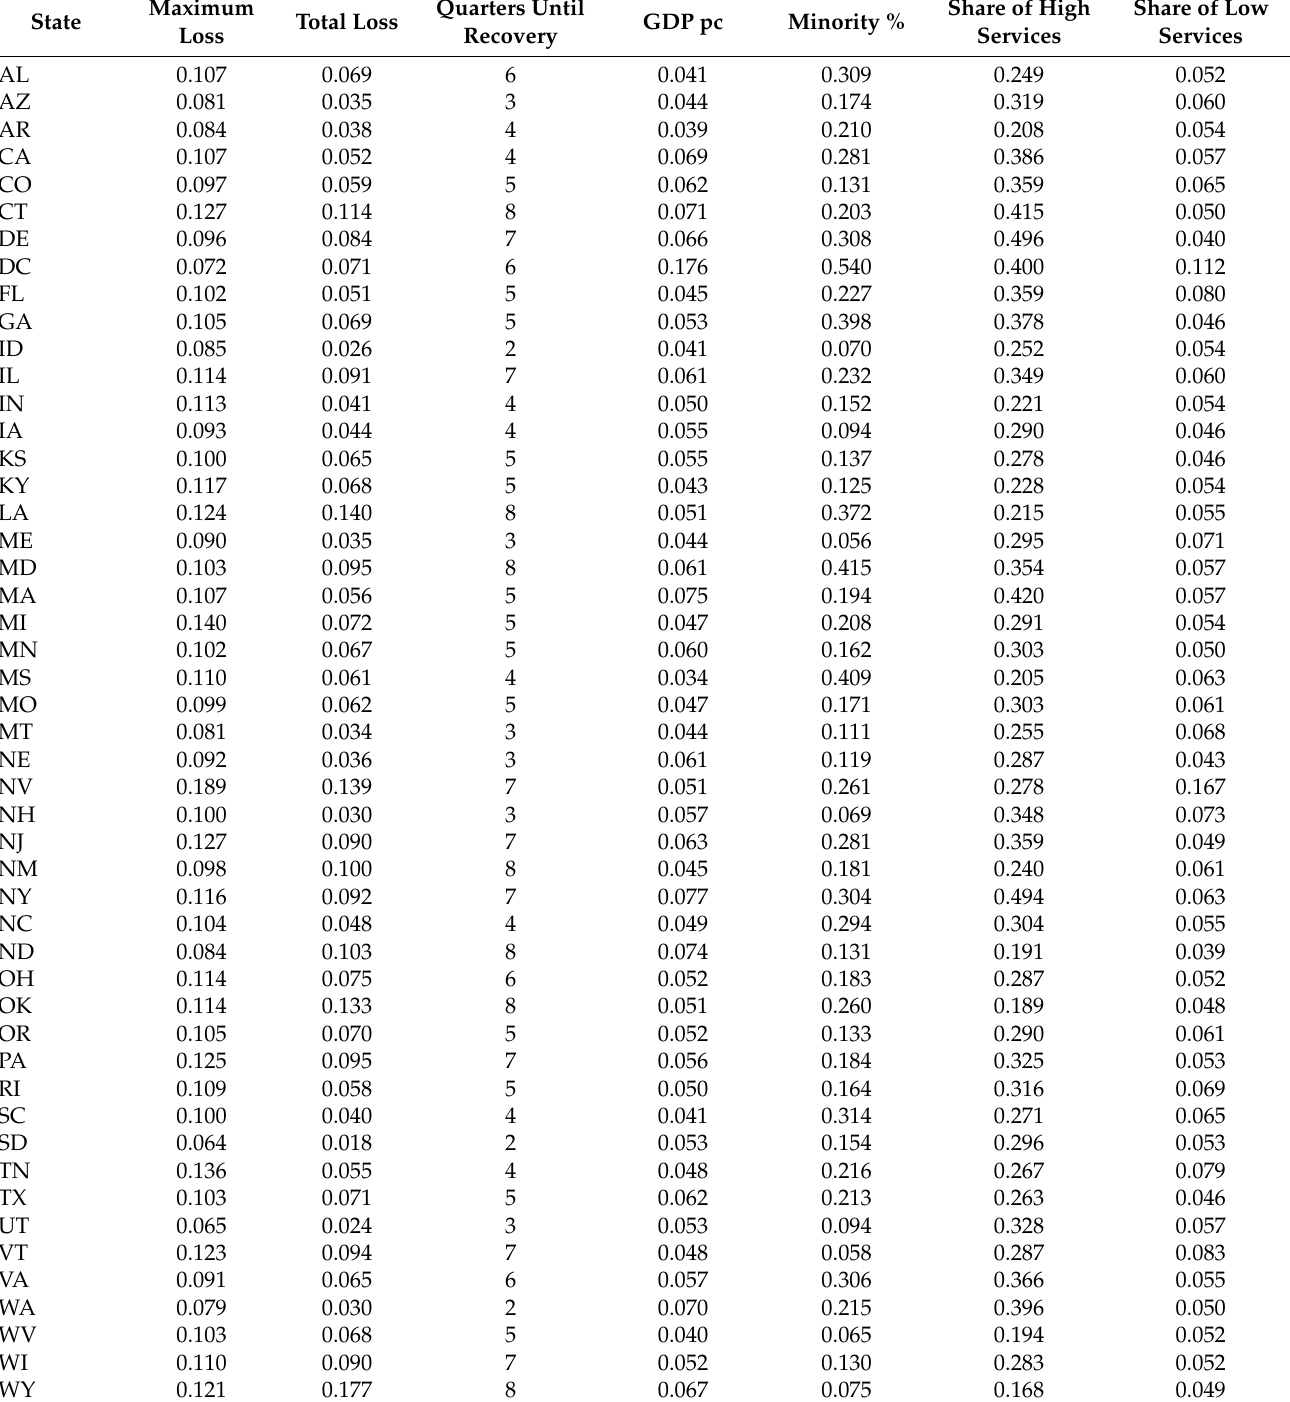
Table A1. Database for the analysis of the association between the socio-economic characteristics of the states and pandemic-induced economic losses (represented by either maximum loss, total loss, or the number of quarters until GDP recovered to the level of the 4th quarter of 2019). See Sections 2.2 and 3.3 for the